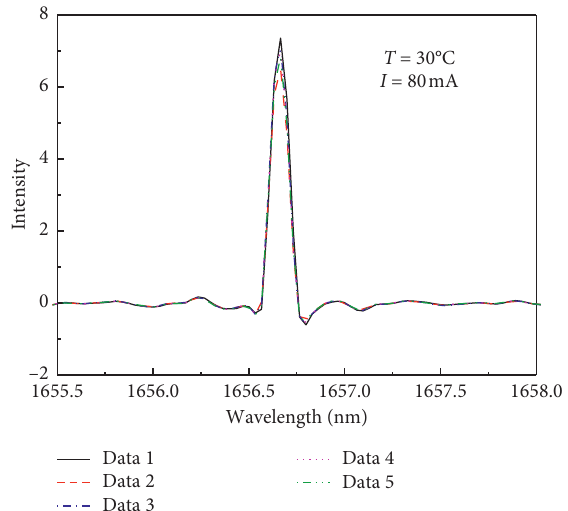
Figure 11: Spectroscopy stability test of the DFB laser under constant laser and temperature by using the developed